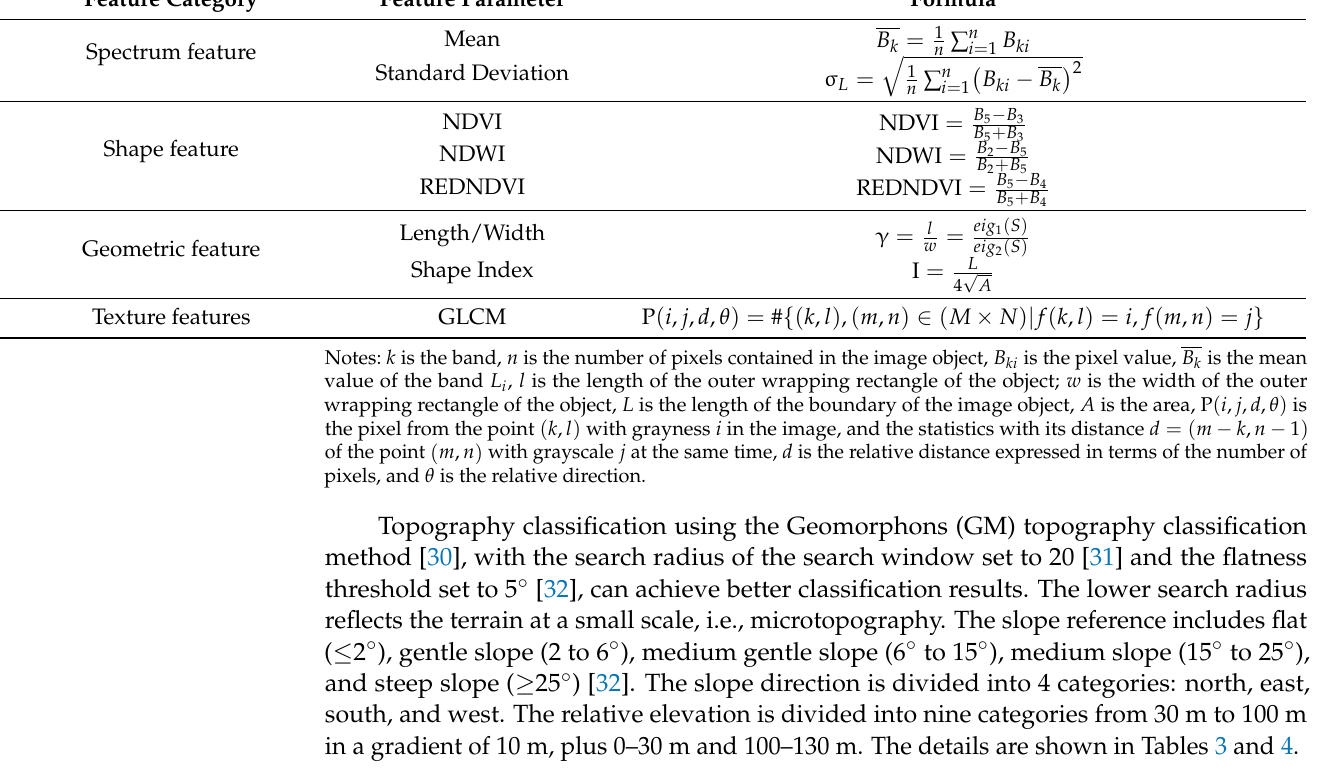
Table 3. Categories of terrain, slope, and